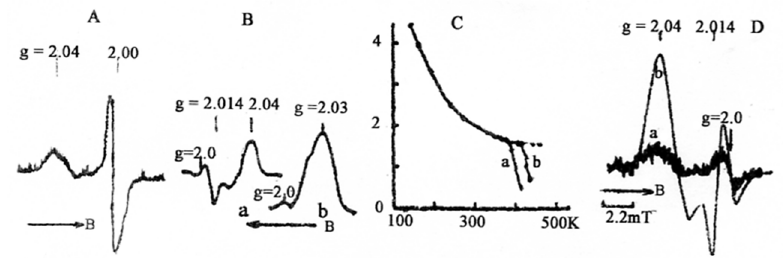
Figure 1. Results of first EPR studies of the 2.03 signal (1963–1966). ( A ) the first recording of the component of the 2.03 signal at g ⊥ = 2.04 in baker’s yeast dried at 30 ◦ C (1963); ( B ) Recording of the full 2.03 signal in dried yeast in 1964 (a)—the first derivative of EPR absorption, (b)—integrated form of EPR absorption with the center at g = 2.03 [43,44]; ( C ) dependence of the 2.03 signal amplitude in dried yeast preparations on the temperature of signal registration (100–500 K) in preparations which were kept in the air (a) or in a vacuum sealed ampoule (b) [44]; ( D ) form of the 2.03 signal registered in moist (a) and dried yeast (b) [45]. Arrows show magnetic field direction.